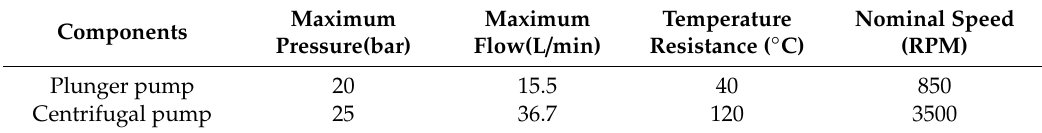
Table 3. Parameters of the plunger pump and centrifugal